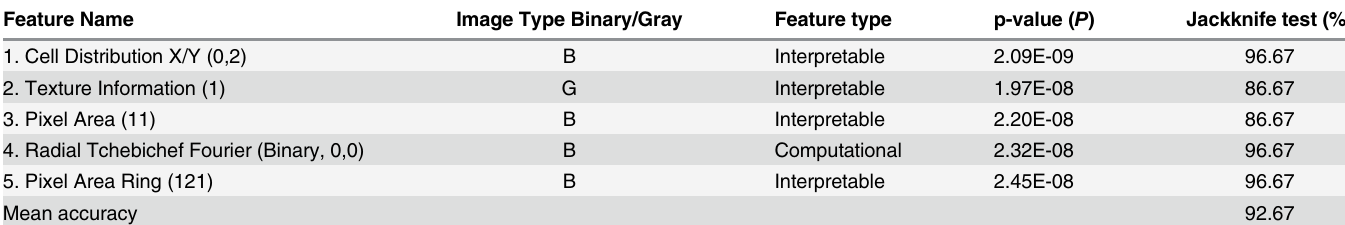
Table 1. The top – 5 features with the smallest P values for astrocytes.